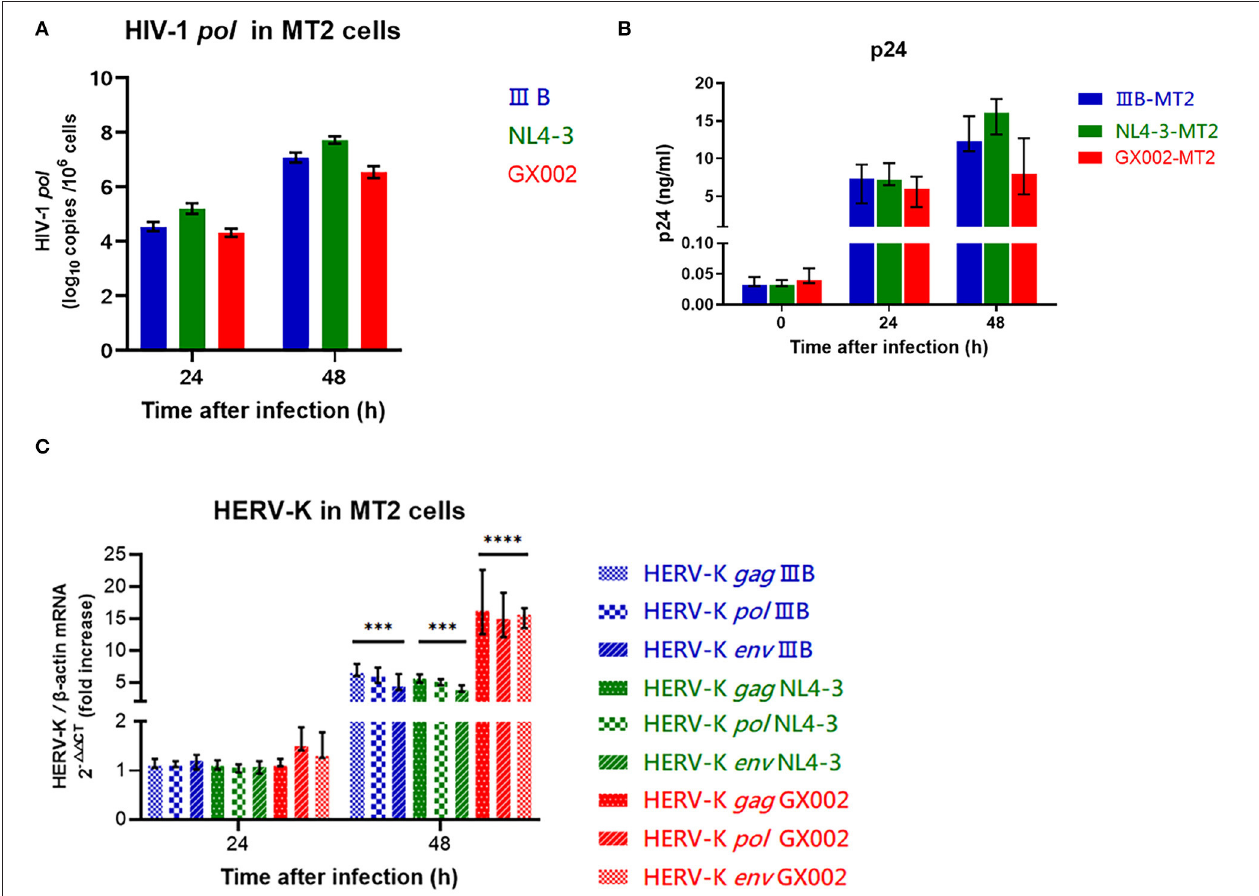
FIGURE 4 | (A) Red represents the GX002 group, blue represents the IIB group, green represents the NL4-3 group. The X-axis is the time of infection. The Y-axis represents log 10 of the HIV-1 pol load, and the units are indicated in the title of the Y-axis. Standard errors for triplicate experiments are indicated. (B) Red represents the GX002 group, blue represents the IIB group, green represents the NL4-3 group. The X-axis is the time of infection. The Y-axis represents the value of p24 antigen, and the units are indicated in the title of the Y-axis. Standard errors for triplicate experiments are indicated. (C) The bars represent the groups indicated in the figure. The X-axis is the time of infection. The Y-axis shows the fold increase in transcription level in the HERV-K gag, pol , env region calculated by the 2 − 11 CT method. Standard errors for triplicate experiments are indicated. * P < 0.05, ** P < 0.01, *** P < 0.001, **** P < 0.0001. All comparisons were relative to uninfected control